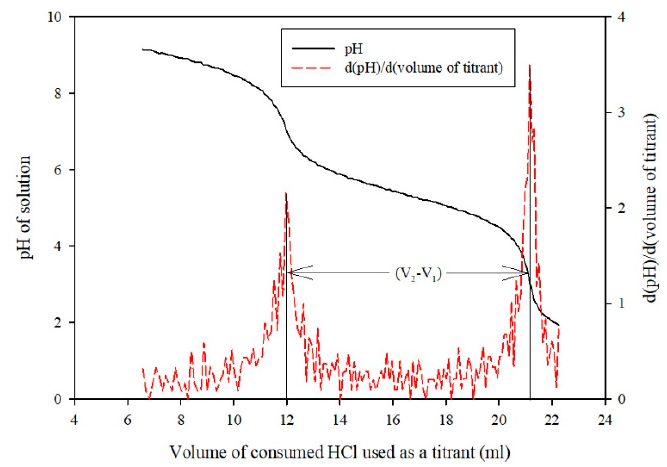
Figure 3. Plot of pH and its differentiation versus volume of consumed titrant, (HCl), for the injection of 50 mL CO 2 through deionized water.